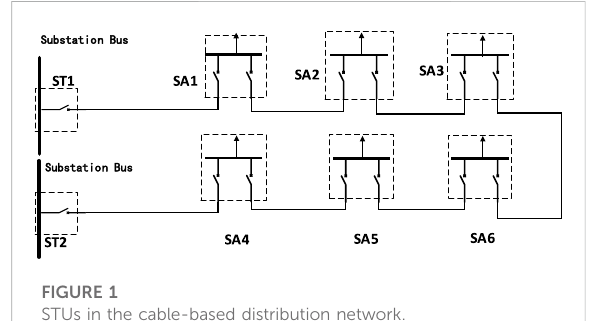
FIGURE 1 STUs in the cable-based distribution